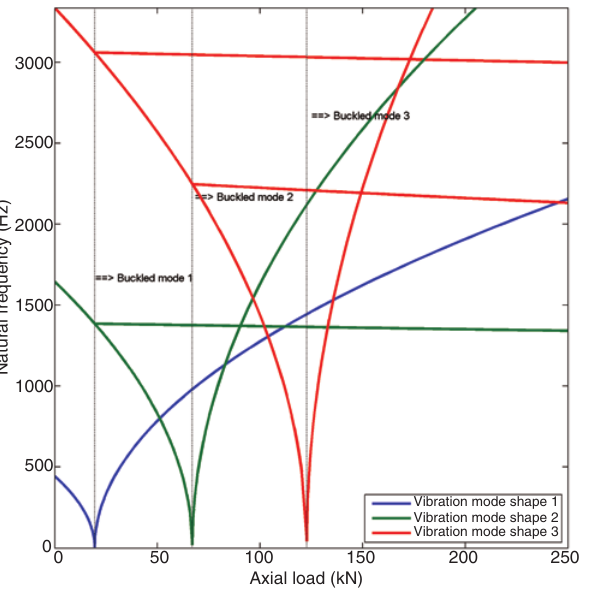
Figure 4 Variation of the natural frequency around the first three buckled configurations with the applied axial load for an SS beam with unidirectional lay-up.